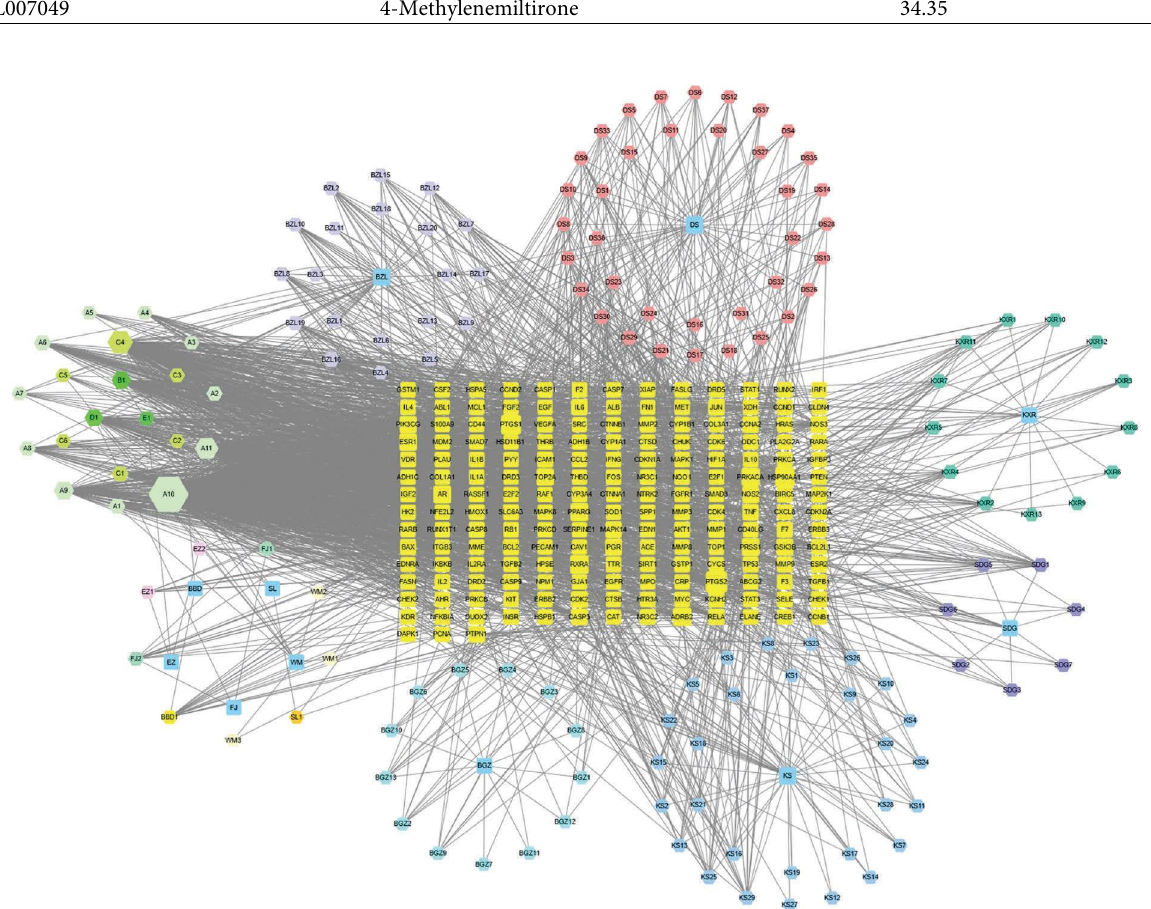
Figure 3: Drug/target/pathway network for SLC and GC. A1–A11, B1, C1–C6, D1, and E1 were common potential active ingredients. Other 21 potential ingredients like wogonin and rhamnazin had high degrees and betweenness that exceed the average value. Tus, 35 main potential active ingredients were mined for further